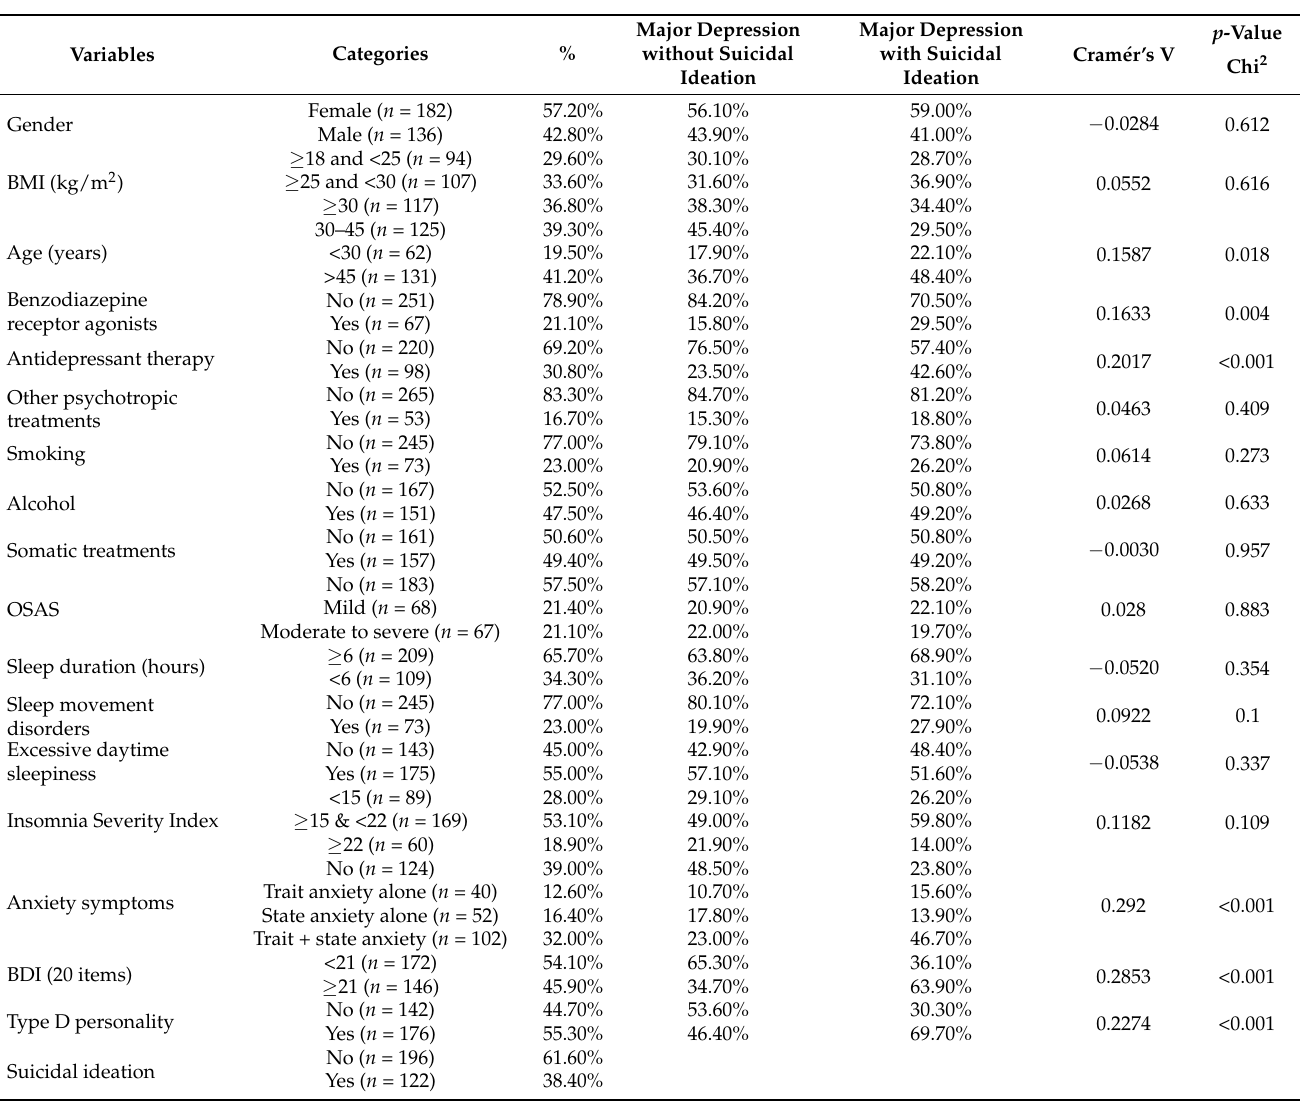
Table 1. Sample Description ( n =